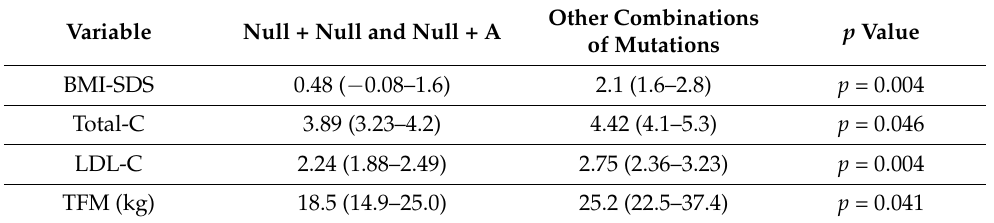
Other Combinations p Value of Mutations